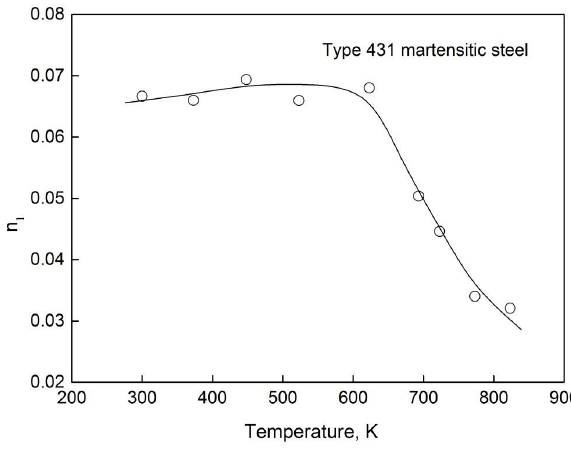
Figure 14: Variation of Ludwigson / Hollomon work hardening pa- rameter n 1 with temperature for the AISI 431 steel.